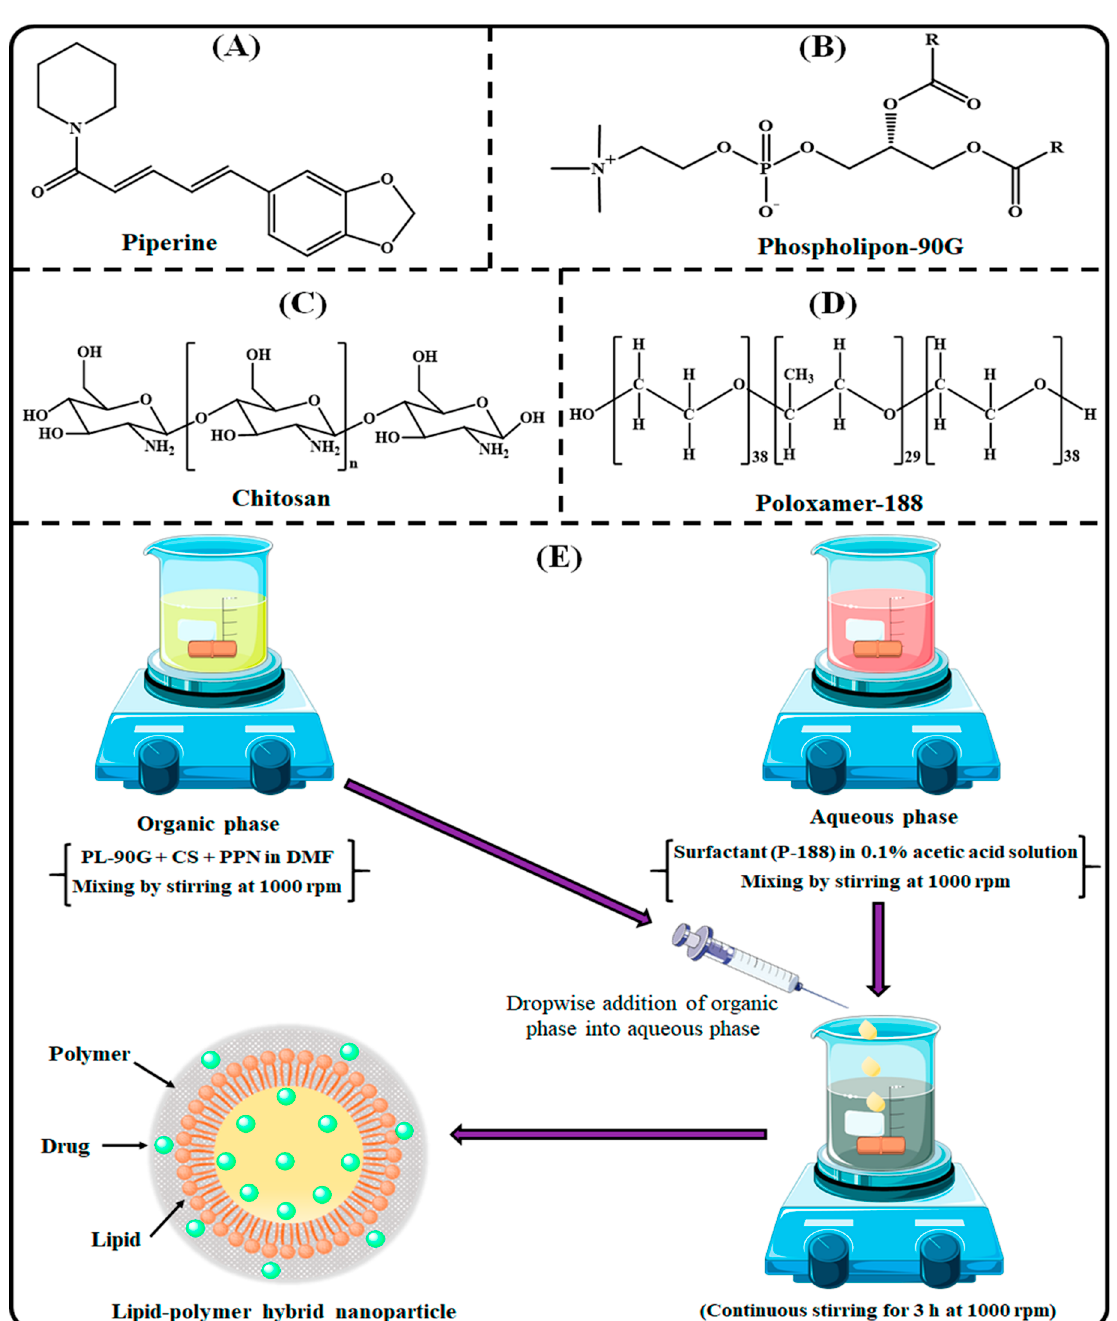
Figure 1. Image illustrating the chemical structure of ( A ) PPN, ( B ) PL-90G, ( C ) CS, ( D ) P-188, and ( E ) scheme for the preparation of PPN-LPHNPs.